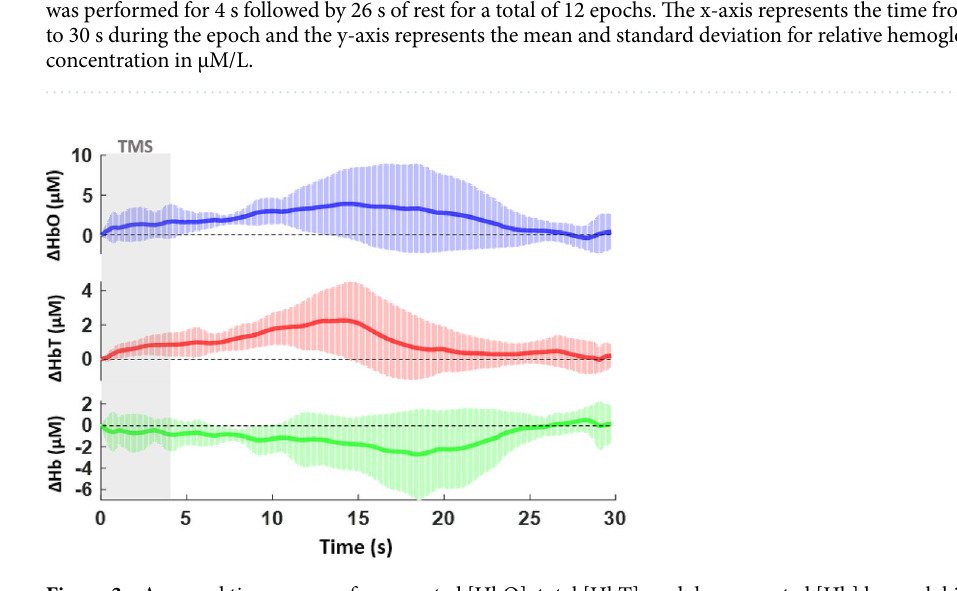
Figure 3. Averaged time course of oxygenated [HbO], total [HbT], and deoxygenated [Hb] hemoglobin signals in the depressed subjects for the contralateral or right dorsolateral prefrontal cortex. Ten hertz stimulation was performed for 4 s followed by 26 s of rest for a total of 12 epochs. The x-axis represents the time from 0 to 30 s during the epoch and the y-axis represents the mean and standard deviation for relative hemoglobin concentration in